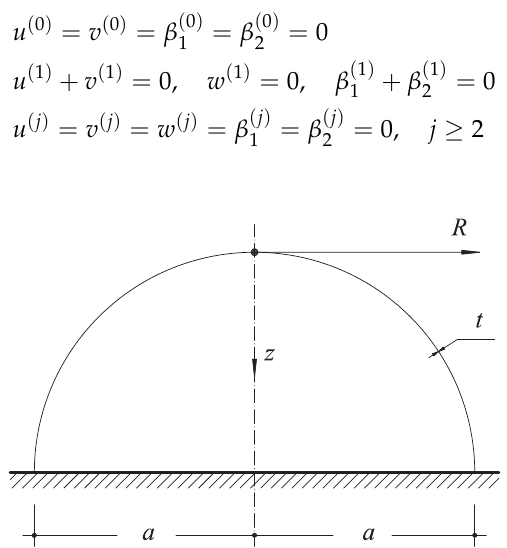
Figure 3. Clamped hemispherical shell in free vibration. Cross